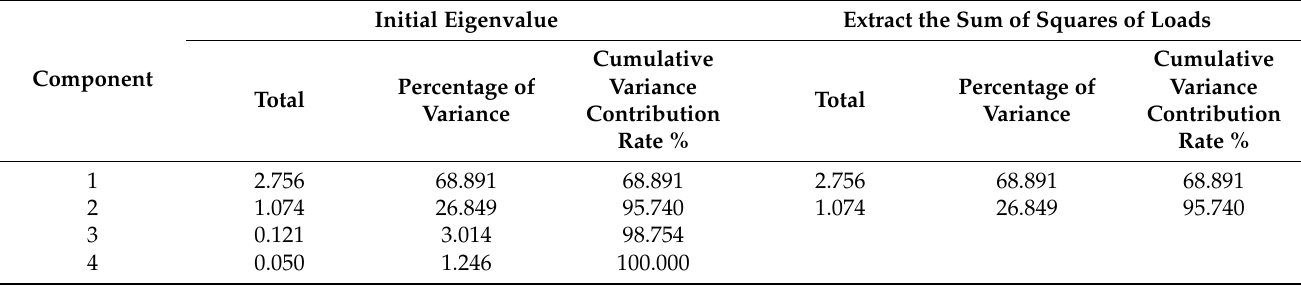
Table 5. Contribution of principal components and cumulative